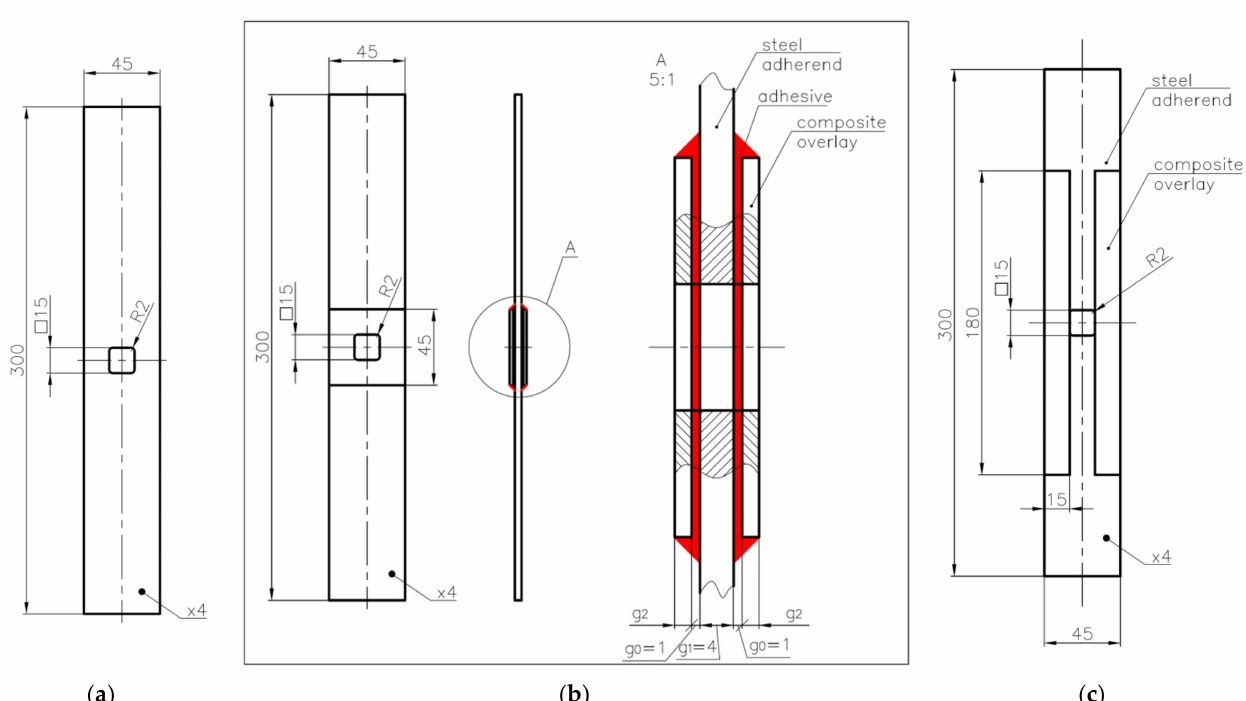
Figure 2. Geometry of tested samples with square notches with rounded corners: ( a ) without composite overlays—samples 16 and 17; ( b ) with two 45 × 45 mm composite overlays with hole at centre on both sides—samples 18–21; ( c ) with four rectangular 15 × 180 composite overlays on both sides—sample no.